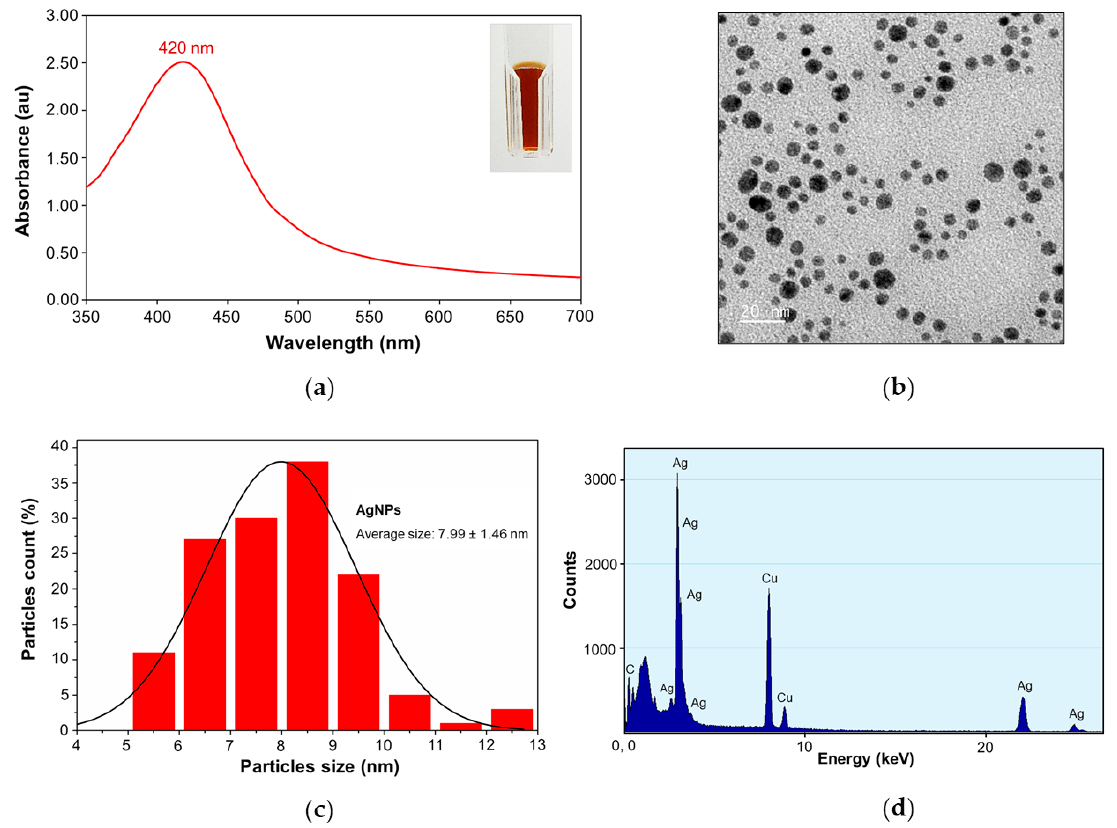
Figure 1. Physicochemical characterization of silver nanoparticles: ( a ) UV-Vis spectra of silver nanoparticles at 420 nm, inset: the dark yellow color of AgNPs; ( b ) transmission electron micrograph (TEM) of AgNPs showing the NPs spherical shape; ( c ) the average size of 7.99 ± 1.46 nm ( n = 137); ( d ) and the EDX spectrum of AgNPs.